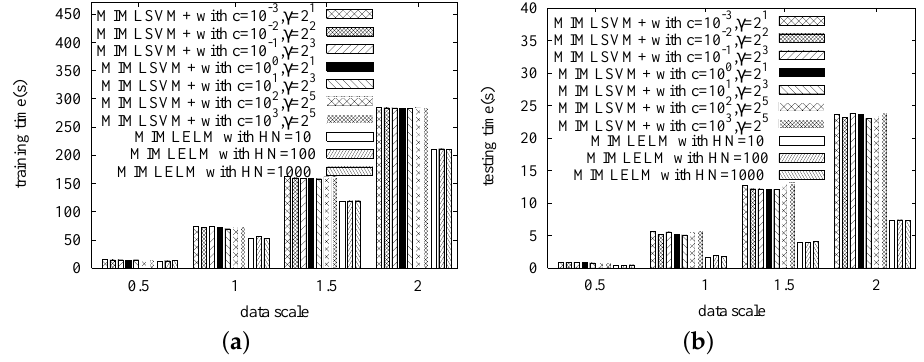
Figure 6. The efficiency comparison on the Text dataset. ( a ) The comparison of the training time; ( b ) the comparison of the testing time.